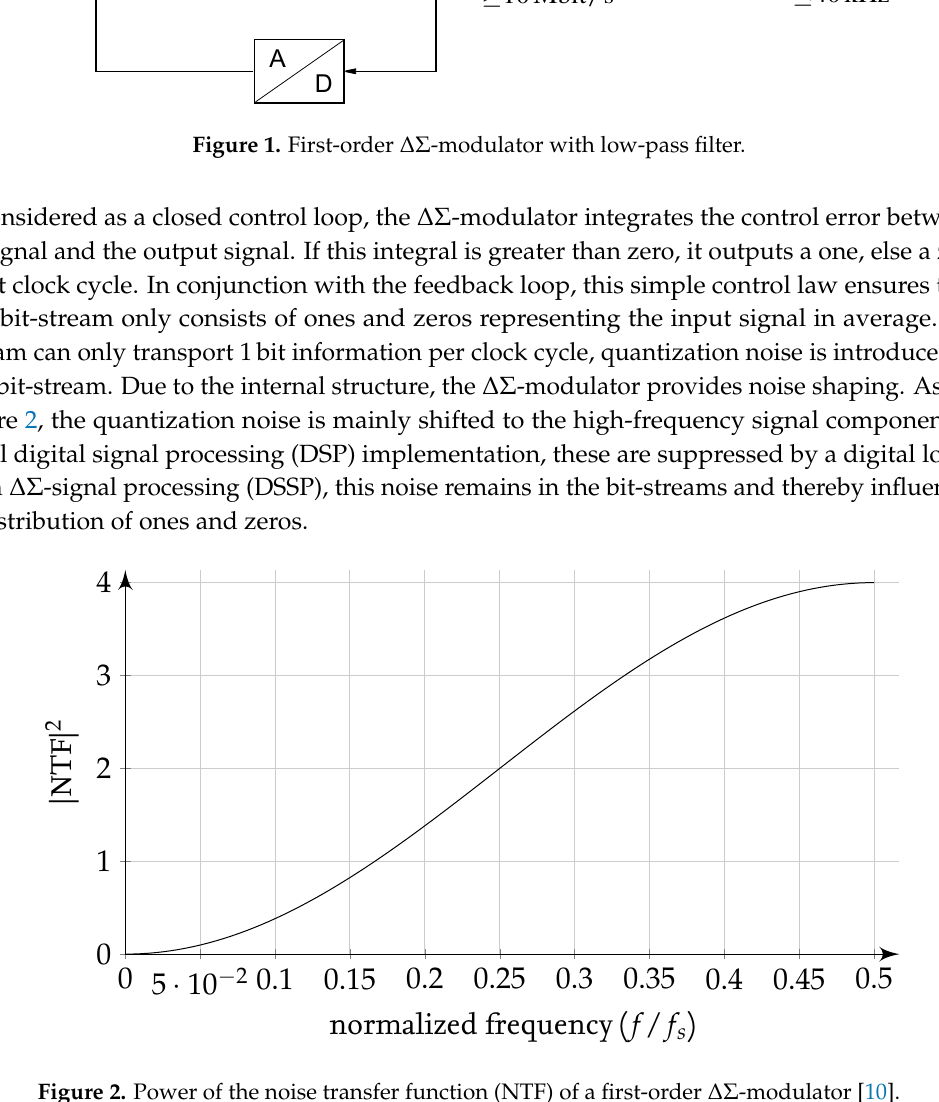
Figure 2. Power of the noise transfer function (NTF) of a first-order ∆Σ -modulator